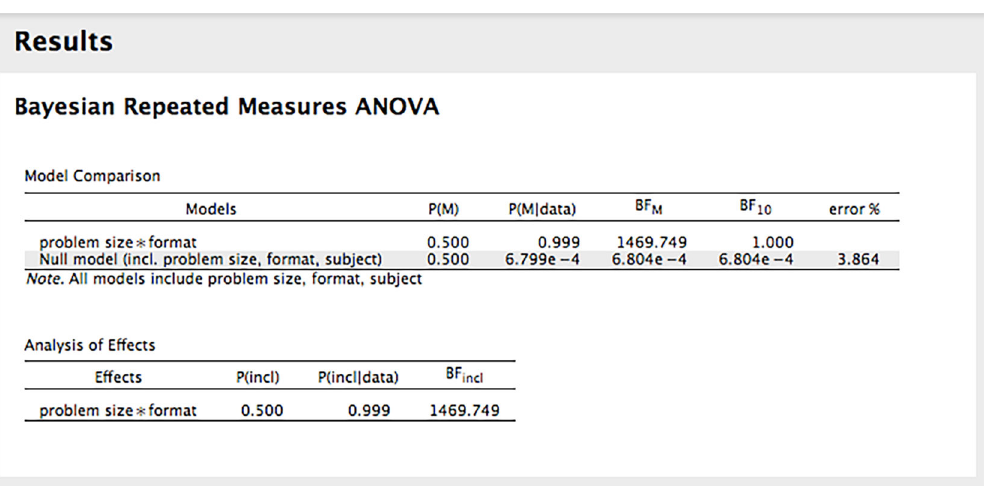
Figure 13. Output tables for the Bayesian Repeated Measures